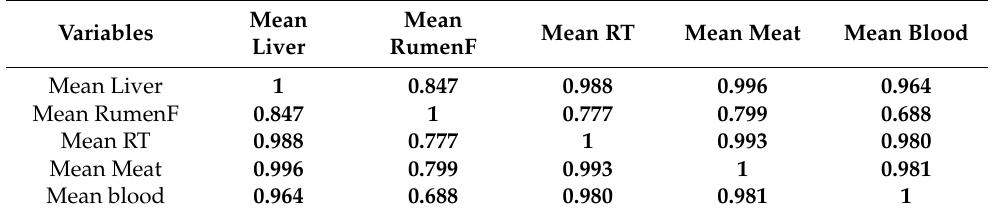
Table 15. Matrix of correlation of the mean mineral values between the different biological samples. Variables